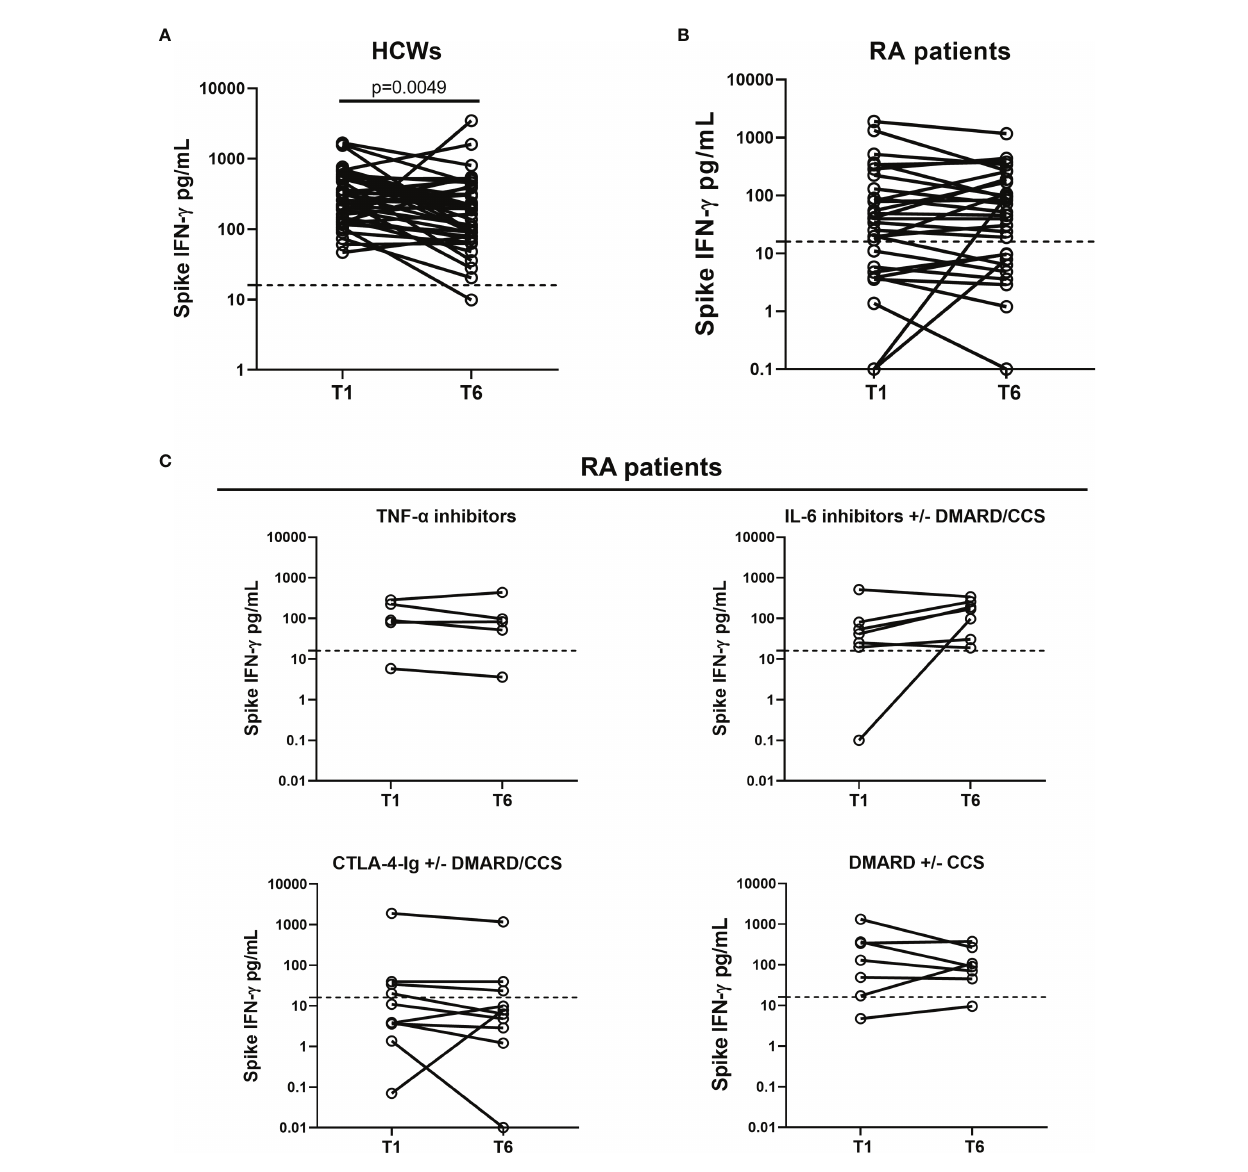
FIGURE 9 | Kinetics of the cell-mediated response induced by SARS-CoV-2 vaccination in HCWs and RA patients. Evaluation of the spike IFN- g response in 42 HCWs (A) and 29 RA patients (B) who were longitudinally sampled after 5 weeks (T1) and 6 months (T6) from the fi rst vaccine dose. (C) RA patients were strati fi ed in four groups: TNF- a inhibitors (n = 5), IL-6 inhibitors with or without DMARD/CCS (n = 7), CTLA-4-Ig with or without DMARD/CCS (n = 10), and DMARD with or without CCS (n = 7). T-cell response to spike antigen was assessed by measuring IFN- g levels in plasma harvested from stimulated whole-blood samples. IFN- g values were reported as median after subtracting the background. Dashed lines indicate the cutoff (spike: 16 pg/ml). Statistical analysis was performed using the Wilcoxon test, and p < 0.05 was considered signi fi cant. SARS-CoV-2, severe acute respiratory syndrome coronavirus 2; CCS, corticosteroid; DMARDs, disease- modifying antirheumatic drugs; RA, rheumatoid arthritis; HCWs, health care